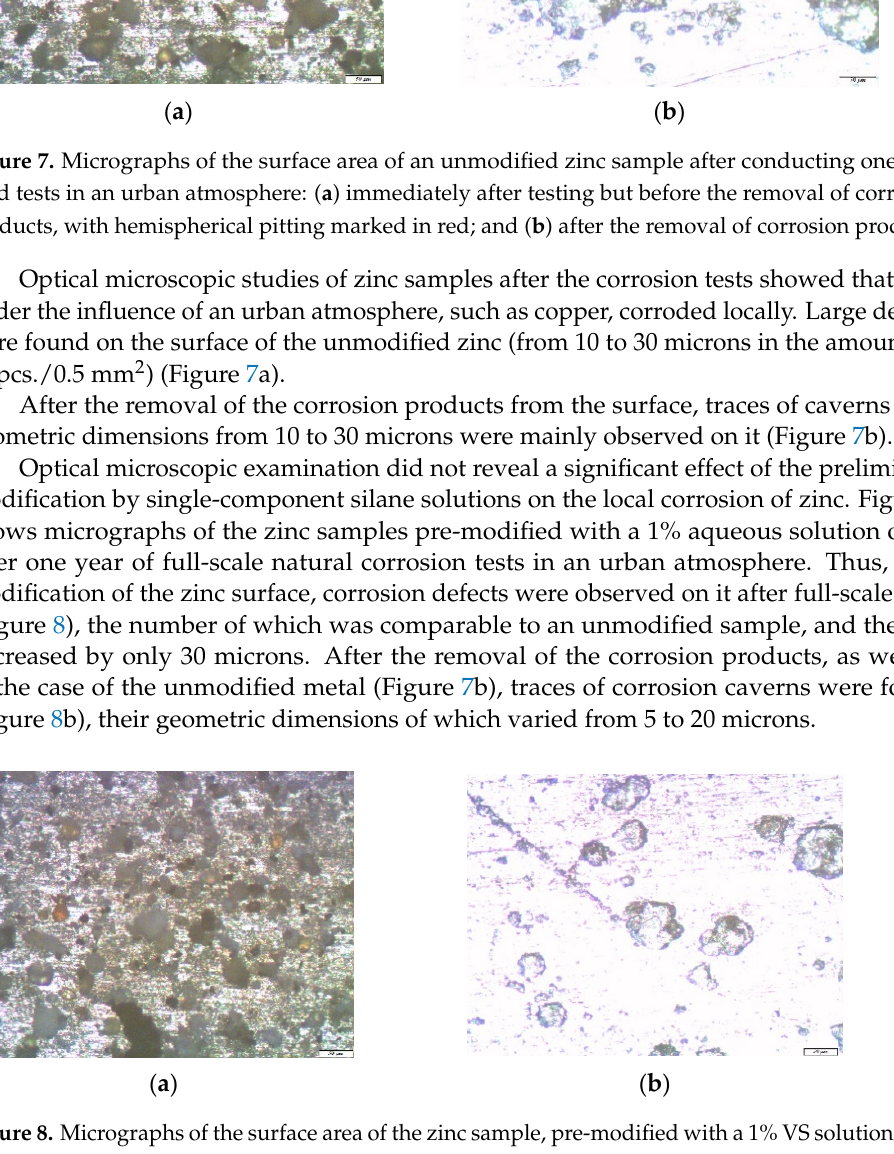
( b ) Figure 9. Micrographs of the surface area of a zinc sample pre-modified with a solution containing a mixture of [1% VS + 1%AS] after conducting full-scale, one-year natural tests in an urban atmos- phere: ( a ) immediately after the tests but before the removal of the corrosion products; and ( b ) after the removal of the corrosion products. Optical magnification of 10x, with defects highlighted in red.